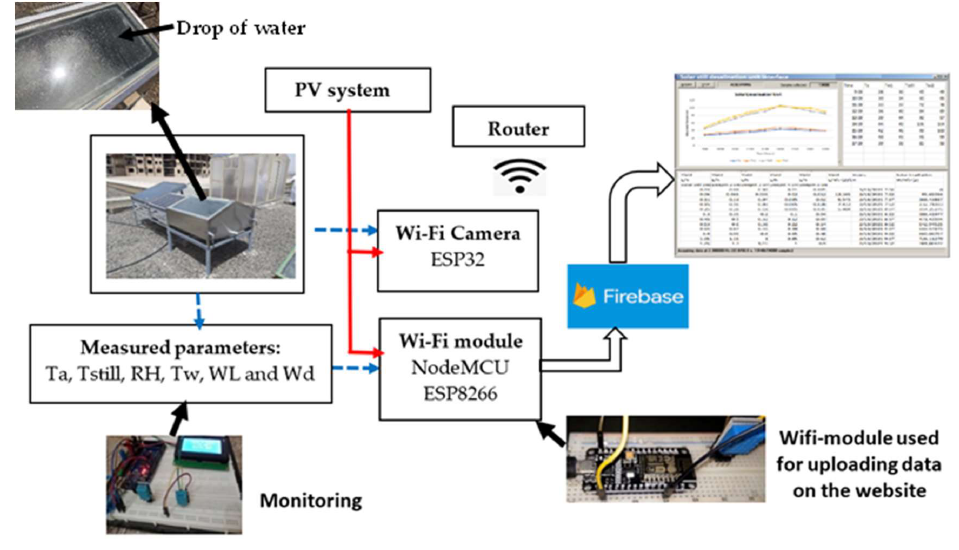
Figure 4. Uploading measured data and images onto the webpage.